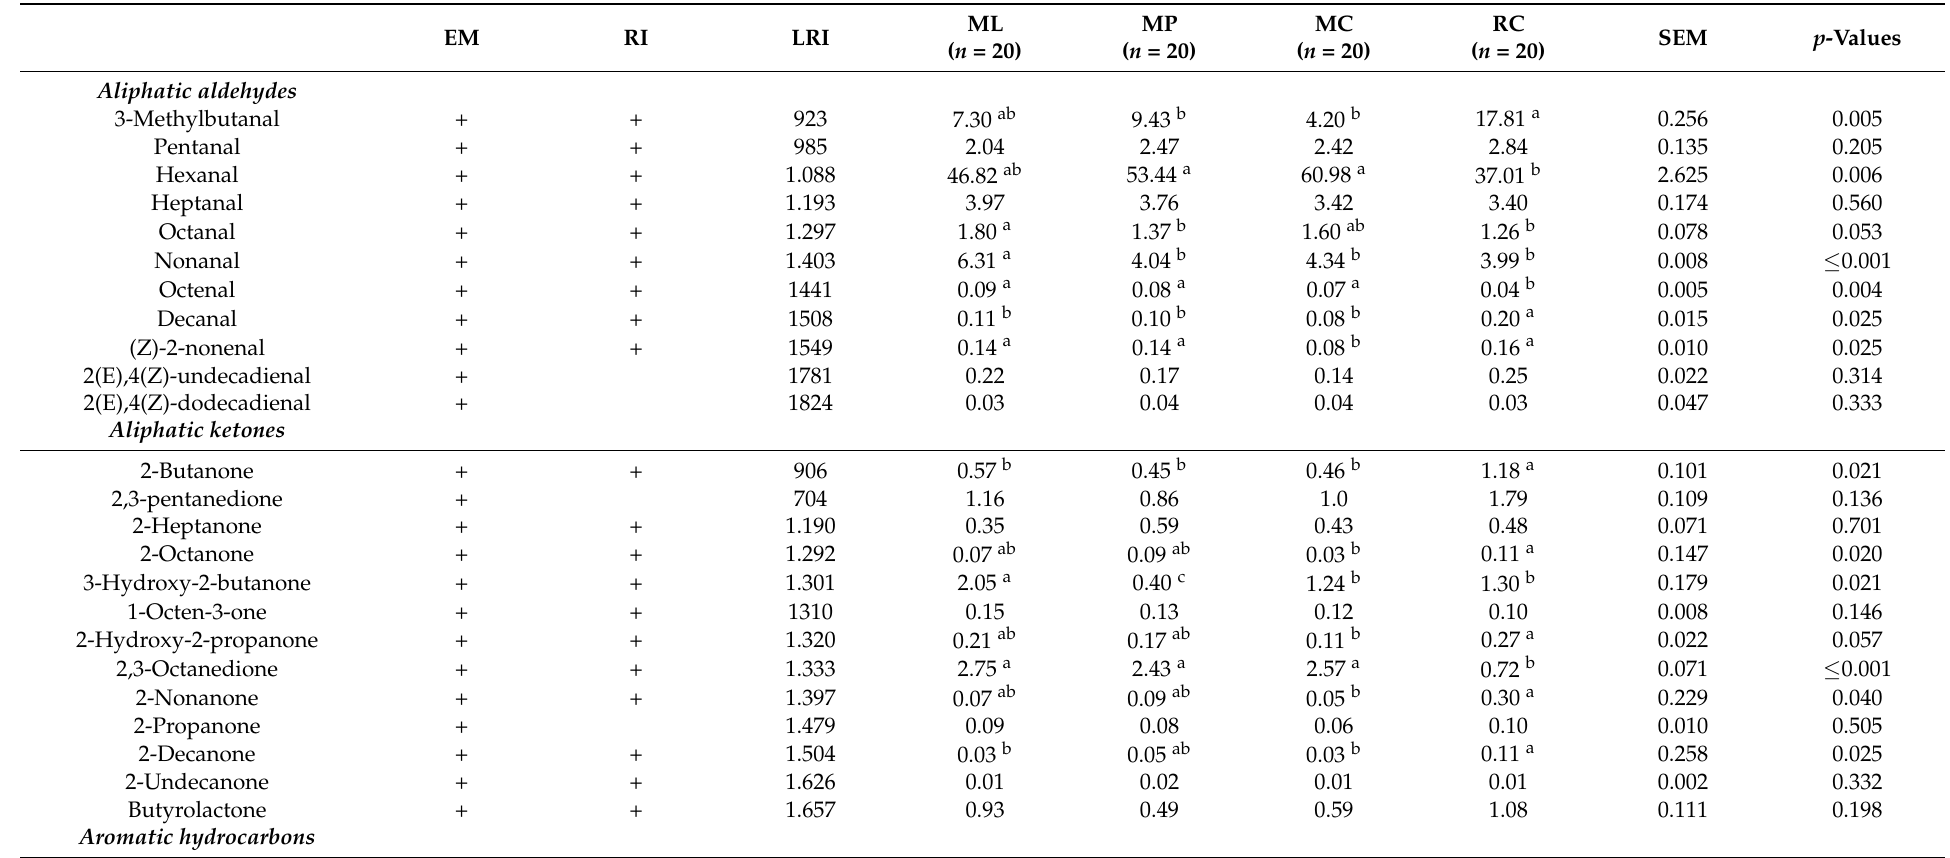
Table 4. Volatile compounds species identified (expressed in %) in intramuscular fat from Mallorquina lambs suckling (ML), grazing (MP), supplemented with grain (MC); and Roja Mallorquina lambs supplemented with grain